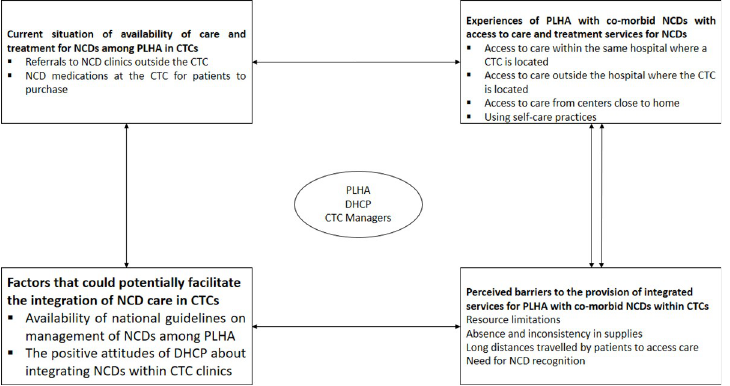
Fig 1. Summary of findings showing how the four themes relate to each other and the categories within each theme.